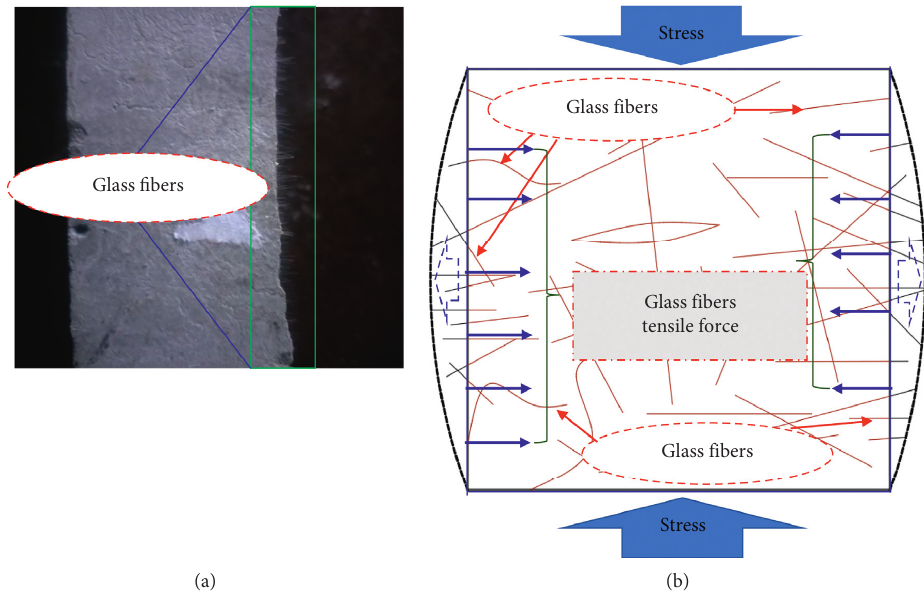
Figure 16: Schematic diagram of the increase in mechanical performance. (a) Photo of the specimen’s inner surface. (b) Schematic diagram of the stress acting on the